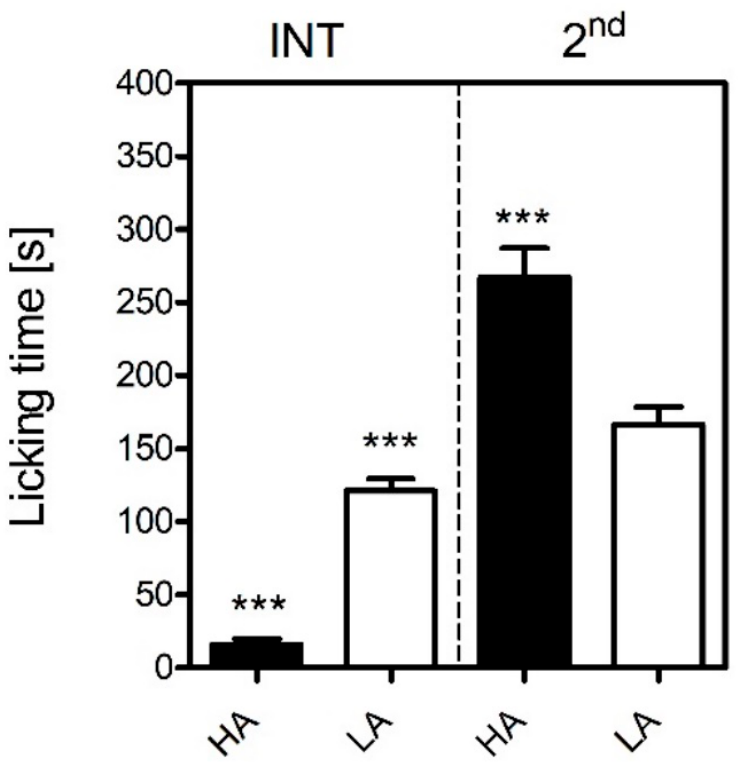
Figure 1. Intensity of acute inflammatory pain in HA and LA mice ( n = 9–13) in the formalin test upon injection of 5% formalin (in PBS) into the dorsum of the hind foot. Paw licking time was measured in the interphase (INT, 5–20 min) and the second phase (2nd, 20–60 min) of the test. Results were analysed with two-way and one-way ANOVA, followed by Bonferroni’s post-hoc test for multiple comparisons. Statistical significance was depicted as follows: *** p ≤ 0.001 (HA vs. LA within each phase).